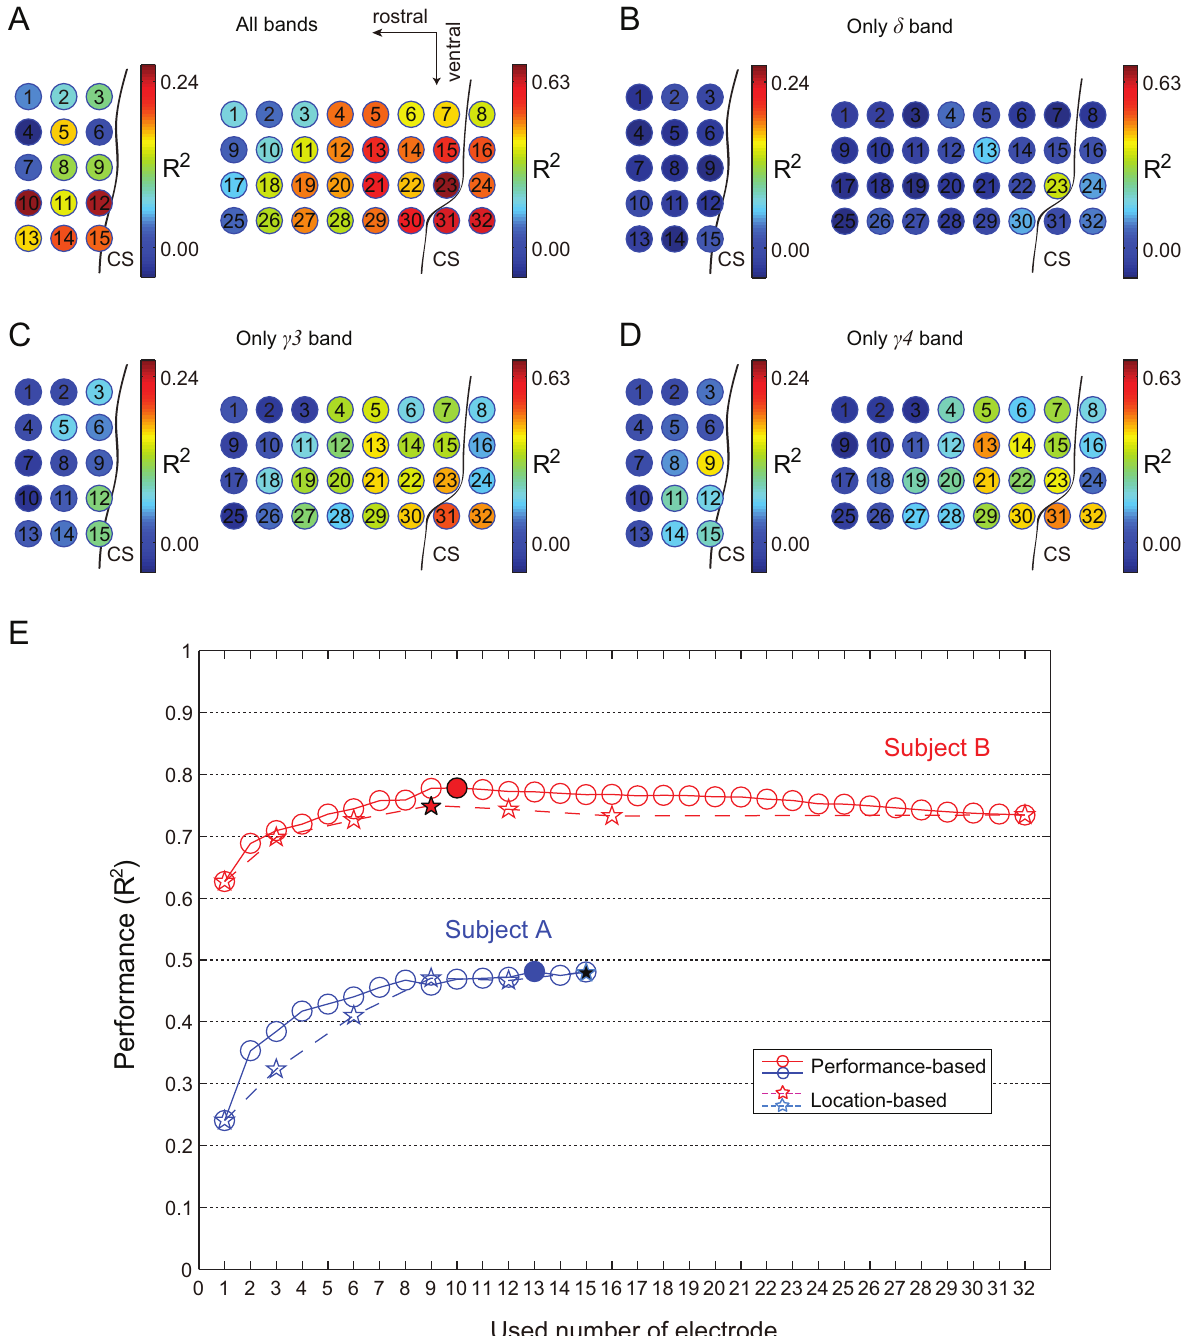
Figure 7. Decoding results for each individual electrode and performance of the two electrode selection methods. A) Prediction performance for each electrode using all frequency bands. The color map in each electrode represents performance of that electrode. R 2 values ranged from 0.00 to 0.24 for monkey A and 0.00 to 0.63 for monkey B. B) Prediction performance of each electrode using the d band. For monkey A, R 2 ranged from 0.00 to 0.24. For monkey B, R 2 ranged from 0.00 to 0.63. C) Prediction performance of each electrode using the c 3 band. For monkey A, R 2 ranged from 0.00 to 0.24. For monkey B, R 2 ranged from 0.00 to 0.63. D) Prediction performance of each electrode using the c 4 band. For monkey A, R 2 ranged from 0.00 to 0.24. For monkey B, R 2 ranged from 0.00 to 0.63. E) The blue solid and blue dotted lines represent the decoding performance for monkey A using the performance-based method and location-based method, respectively. The red solid and red dotted lines represent the decoding performance for monkey B using the performance-based method and location-based method, respectively. The solid stars and circles denote the highest performances for the performance-based method and location-based method, respectively.